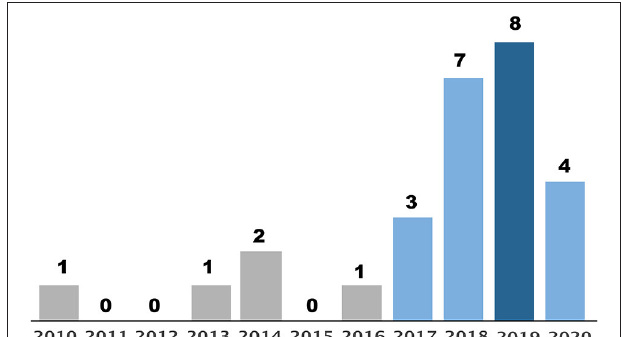
FIGURE 2 | Establishment of community seed banks in China over time